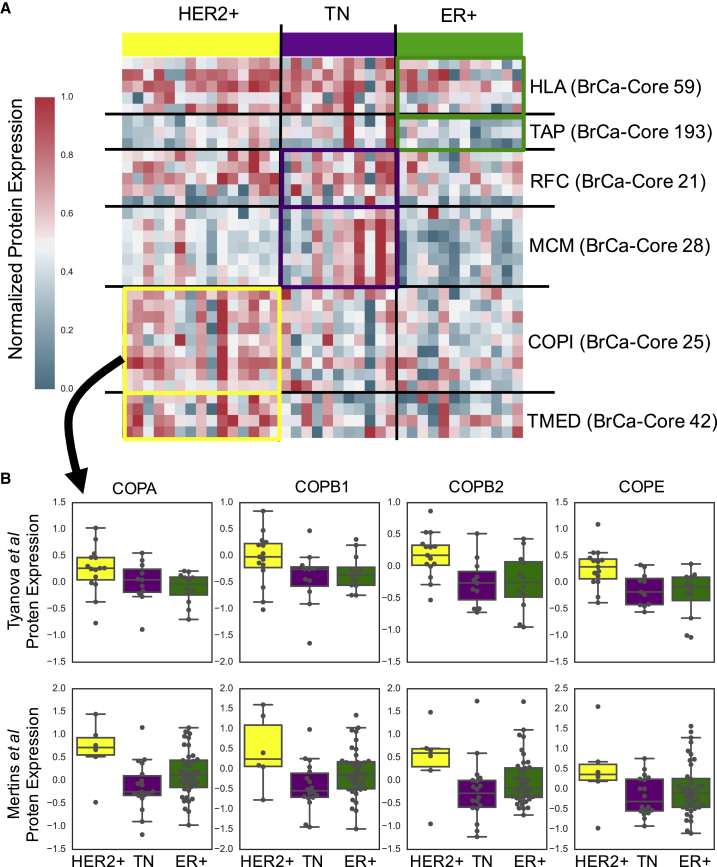
Subtype-Specific Complex Expression(A) Heatmap displaying protein expression levels of specific BrCa-Core complexes. Tumor samples are grouped according to subtype (using IHC markers), indicated on top of the heatmap. Genes are grouped into specific complexes indicated on the right of the heatmap. Shown are the expression levels taken from Tyanova et al., 2016 (used for validation). These expression levels have been normalized such that the maximum expression level is 1 and minimum is 0. Heatmap for the discovery dataset (Mertins et al., 2016) is shown in Figure S2A. Complexes differentially expressed in specific subtypes are highlighted with boxes colored to match the subtype they are differentially expressed in.(B) Boxplots displaying the subtype-specific protein expression levels of selected subunits of the COPI complex (BrCa-Core 25) in the Tyanova et al. dataset (top) and TCGA dataset (bottom). These boxplots show median and interquartile range and are colored according to sample subtype (matching Figure 2A).